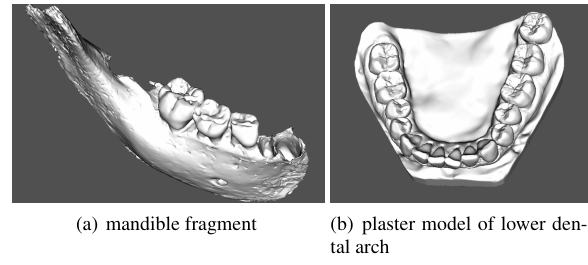
Figure 1. Mandible fragment (modern history) and plaster model of lower dental arch images: laboratory scanners